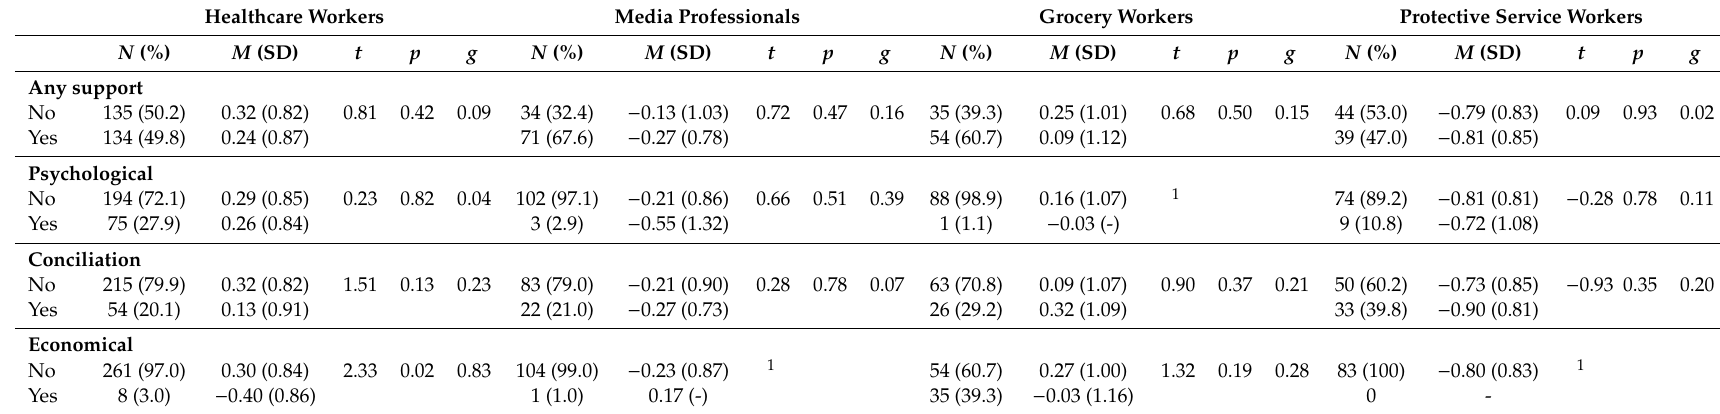
Table 6. Support received by the hiring company during the COVID-19 crisis and association with psychological impact (IES-R standardized score). Healthcare Workers Media Professionals Grocery Workers Protective Service Workers